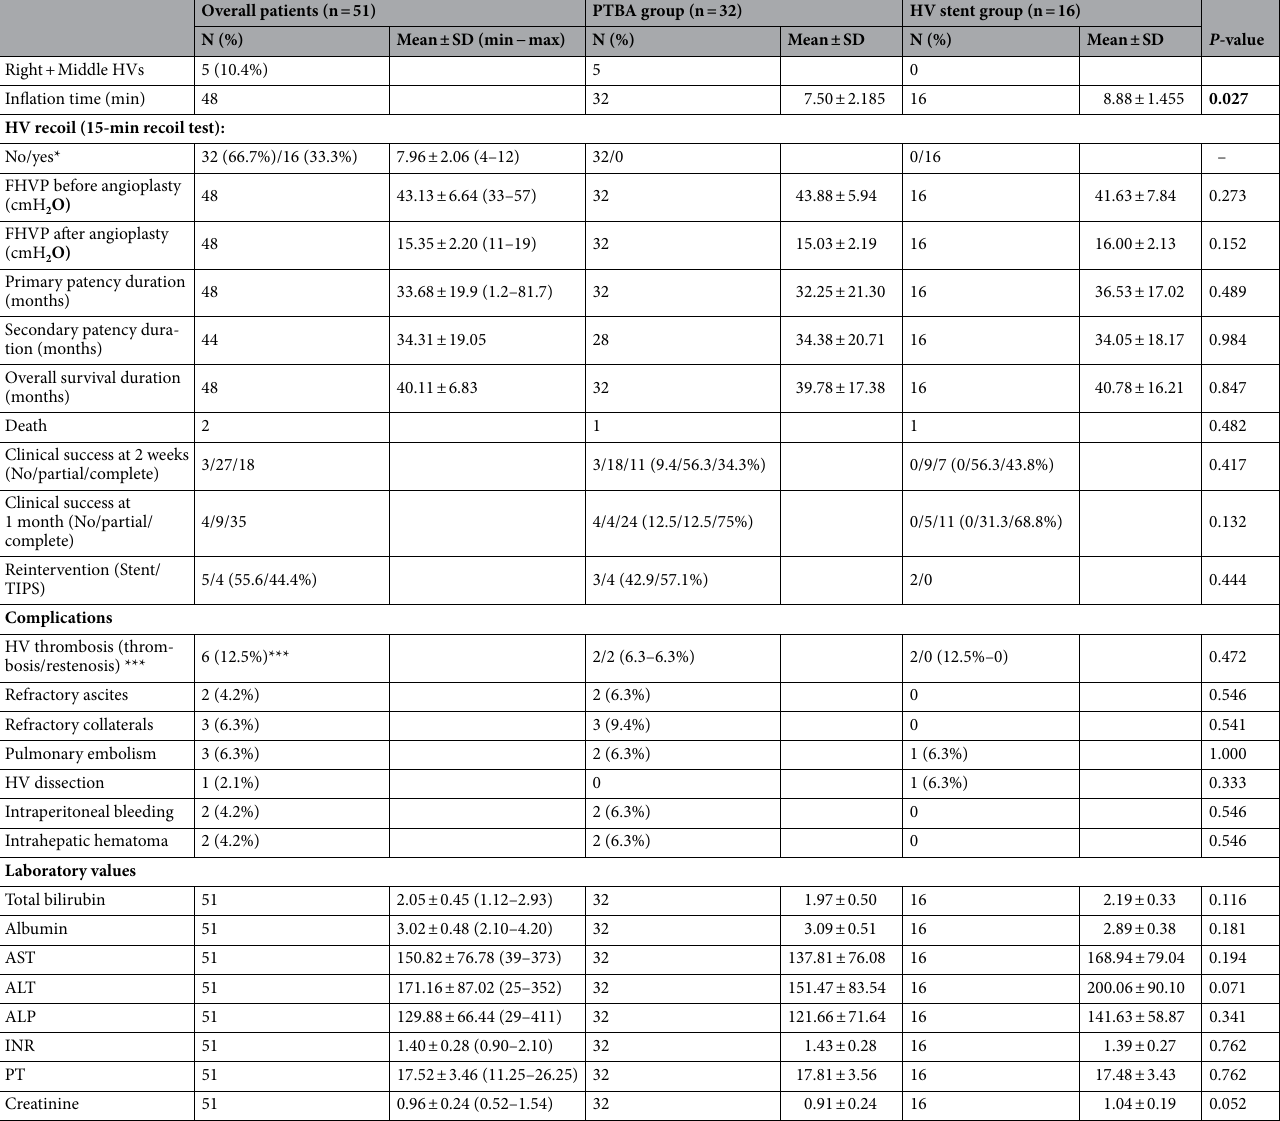
Table 1. Patient demographics in the total study population versus subgroups managed with hepatic vein angioplasty alone and those managed with additional HV stent. MELD model for end-stage liver disease, HV hepatic vein, FHVP free HV pressure, AST aspartate aminotransferase, ALT alanine aminotransferase, ALP alkaline phosphatase, INR international normalized ratio, PT prothrombin time. *Including 2 patients (4.2%) with membranous obstruction in whom HV restenosis occurred. **Fisher’s exact test. ***Including 4 patients (8.3%) with membranous obstruction with immediate recoil following dilatation and 12 patients with segmental obstruction (25%) in whom HV re-thrombosis